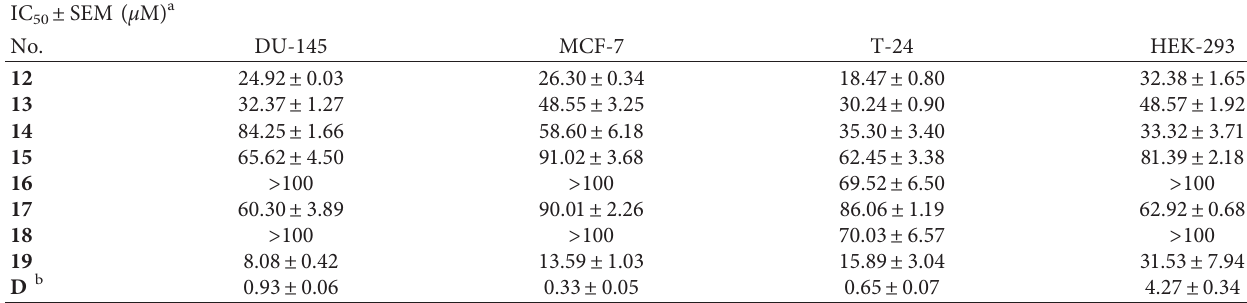
Table 1: In vitro cytotoxic activity of 12–19 on DU-145 (prostate), MCF-7 (breast), T-24 (bladder) cancer cell lines, and HEK-293 human embryonic kidney cells (nontumor